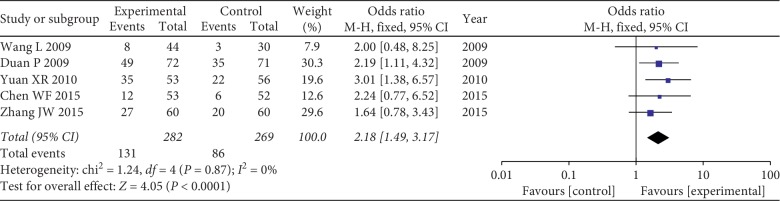
Forest plot of KPS.